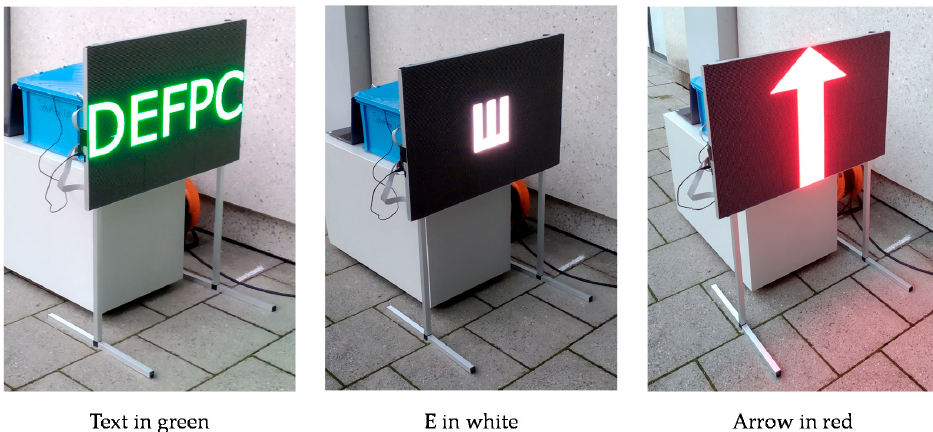
Figure 2. The external human–machine interface (eHMI) prototype developed and evaluated in the present investigation. The content colors do not match the real colors due to the display angle and camera